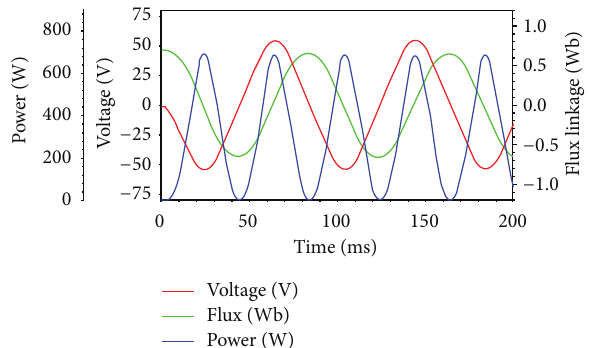
Figure 14: Generated power with voltage and